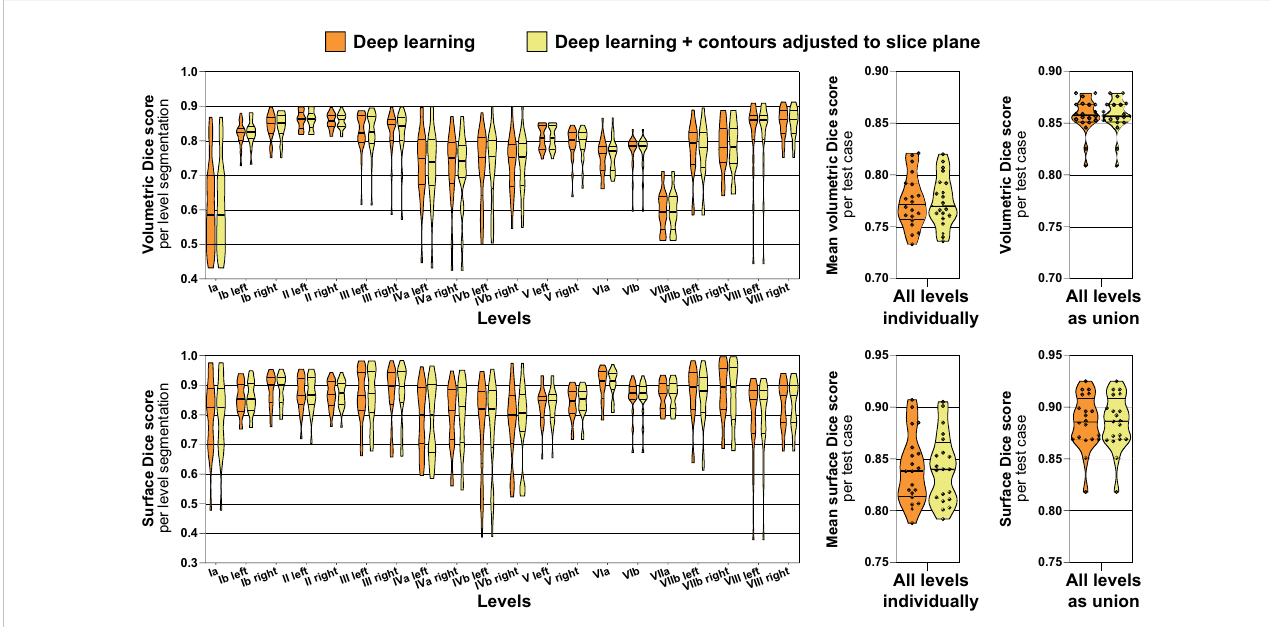
FIGURE 5 Volumetric (top) and surface Dice score metrics (bottom) indicating the similarity of the deep learning lymph node level autocontours to the ground truth expert-generated segmentations (test set n = 20). Orange: Deep learning level autocontours without postprocessing, yellow: deep learning autocontours with CT slice plane adjustment postprocessing applied. The left graphs show volumetric and surface Dice score metrics for each level separately, whereas the center graphs present mean values per test case across all levels. The rightmost graphs show volumetric and surface Dice score for all levels evaluated as a union, i.e., not separating between individual levels. Note: No difference in neither volumetric nor surface Dice score with as compared to without slice plane adjustment postprocessing. Violin plots, thick horizontal lines: median, thin horizontal lines: quartiles, rhombi: individual data